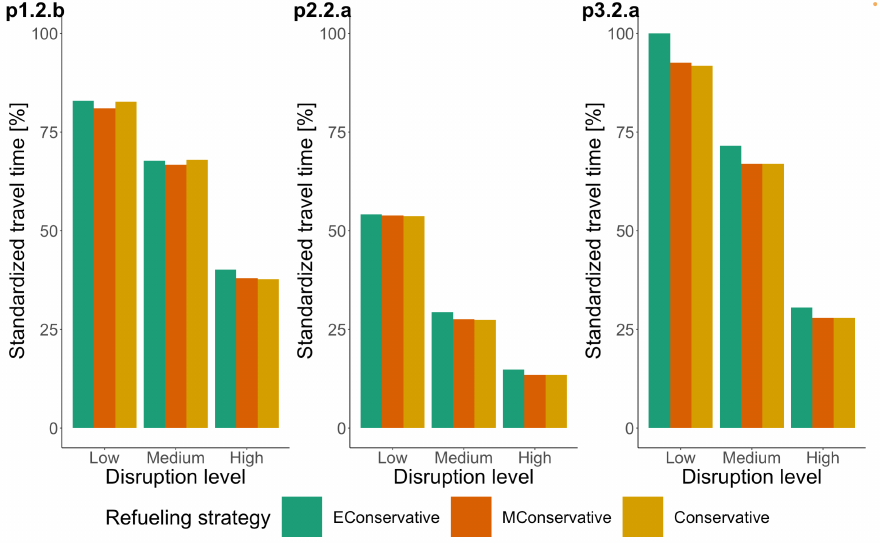
Figure 9. Performance of refueling strategies: normalized travel time of exploration route for instance cluster A. The standardized travel time 100% is equivalent to 21.56 h.